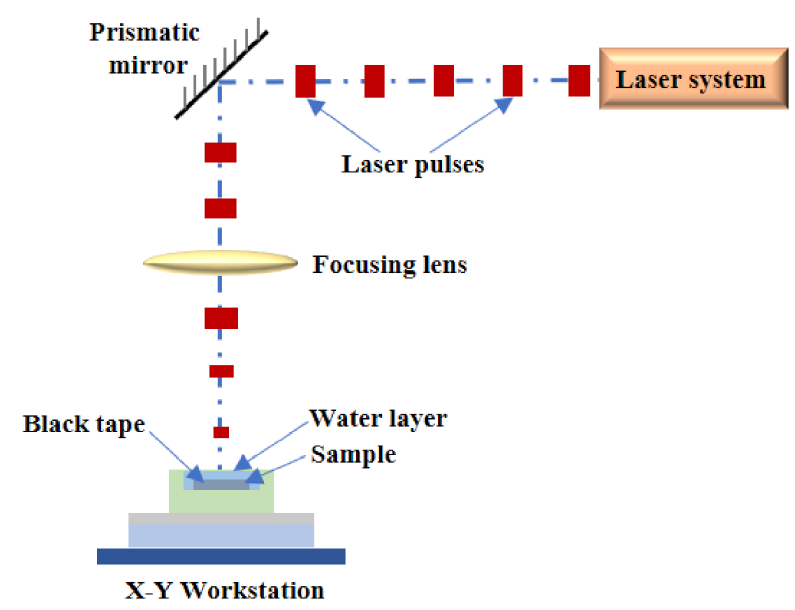
Figure 8. Schematic diagram of the laser shock peening